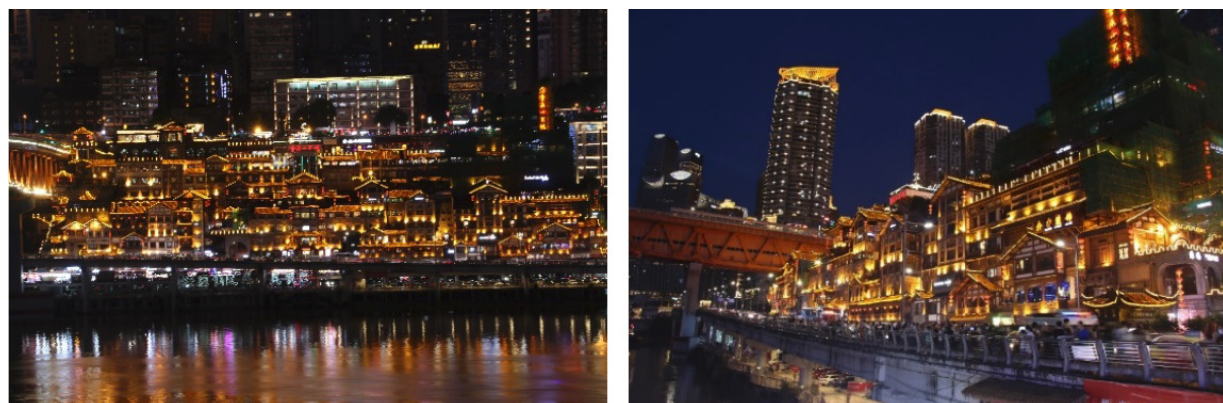
Figure 7. Hongyadong: View from the northern bank (left) and the southern bank (right) of the Jialing River. did not find any novelty in it (Interview,